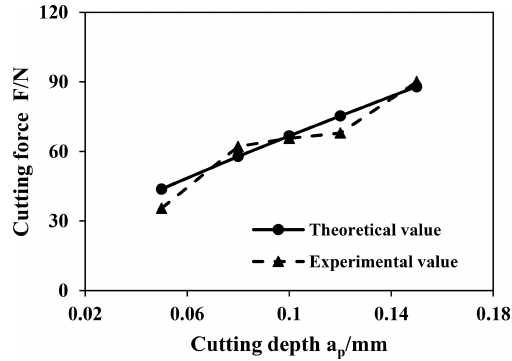
Figure 11. Cutting force varies with cutting